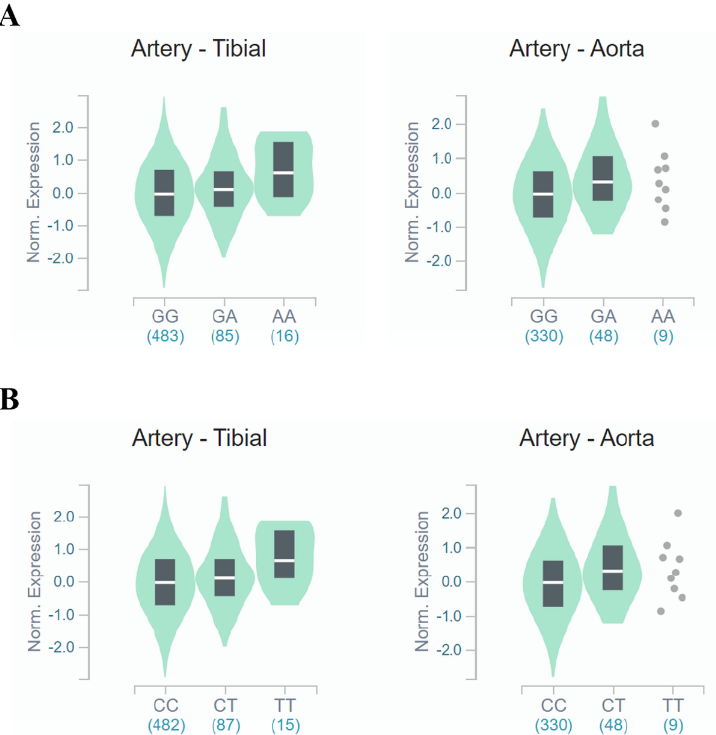
Figure 3. FANCM expression for genotypes rs3783702 ( A ) and rs10138997 ( B ) in the arteries. The data are from the GTExPortal. Gene expression for rs3783702 (tibial artery: β = 0.204, p = 1.2 × 10 − 5 , aortic artery: β = 0.252, p = 6.6 × 10 − 5 ) and rs10138997 (tibial artery: β = 0.211, p = 7.1 × 10 − 6 , aortic artery: β = 0.252, p = 6.6 × 10 − 5 ) genotypes in the arteries was confirmed and were significantly dif- ferent. p -values were calculated by linear regression.